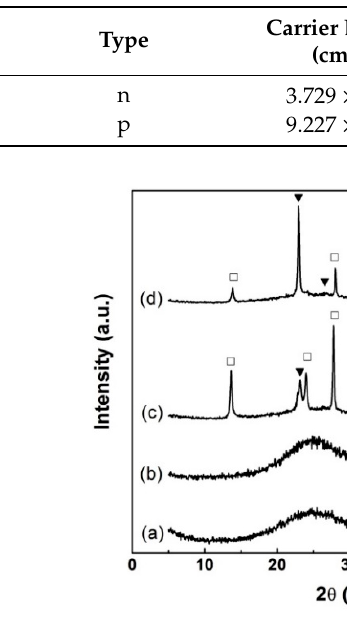
Figure 2. XRD patterns of ( a ) TO1; ( b ) TTO1; ( c ) TO2; ( d ) TTO2: ▼ , WO 3 ; □ , W18O49; ■ , W25O73.